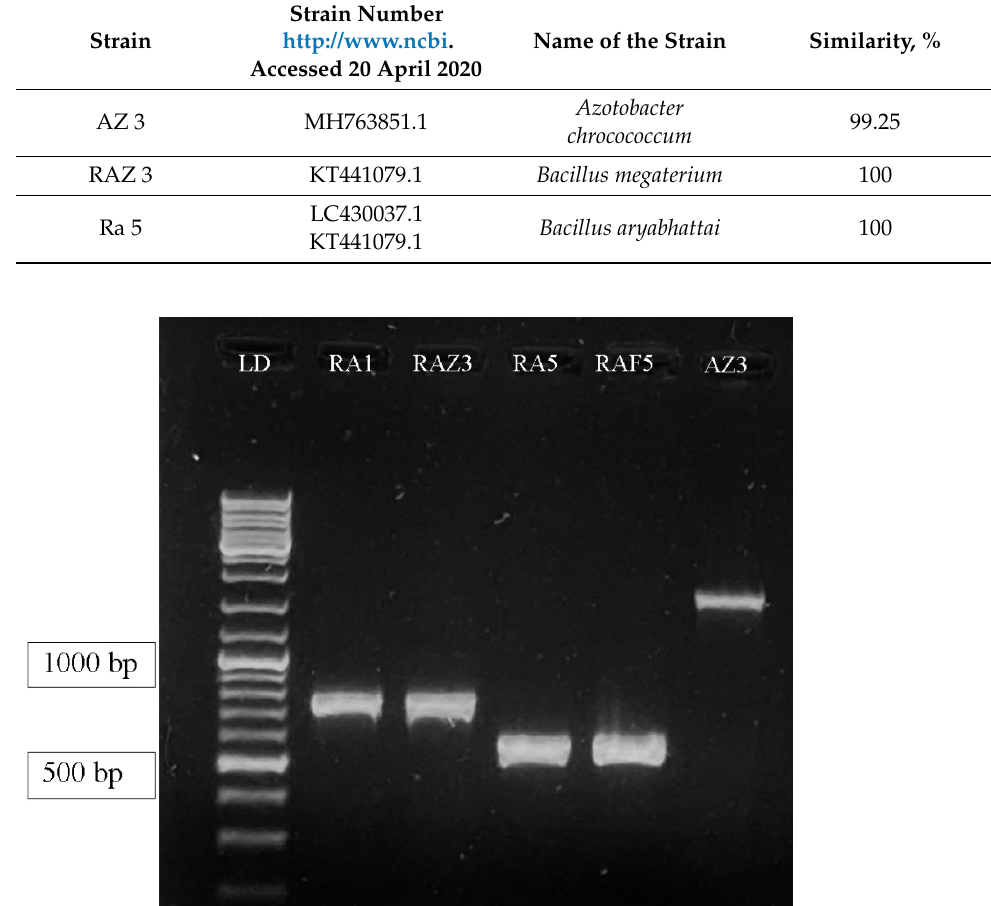
Table 4. Molecular identification of selected P(3HB) positive bacterial isolates. Strain Number Strain